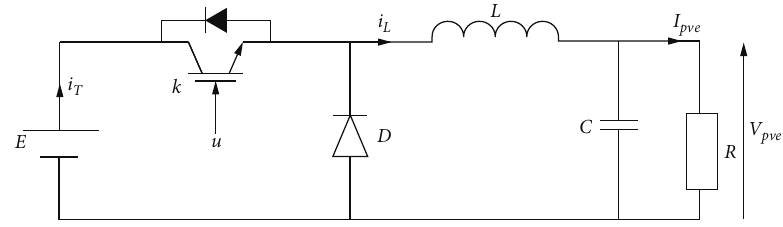
Figure 7: Buck converter electrical circuit.